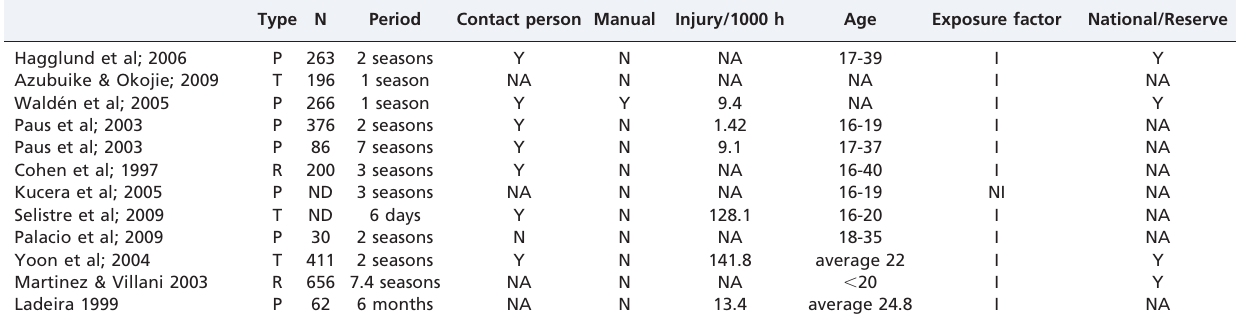
Table 2 - Characteristics of the studies selected for final